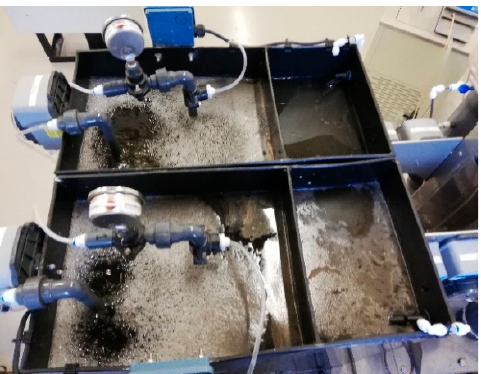
Figure 5. The MBR unit with a membrane compartment and an SNaD during inoculation.